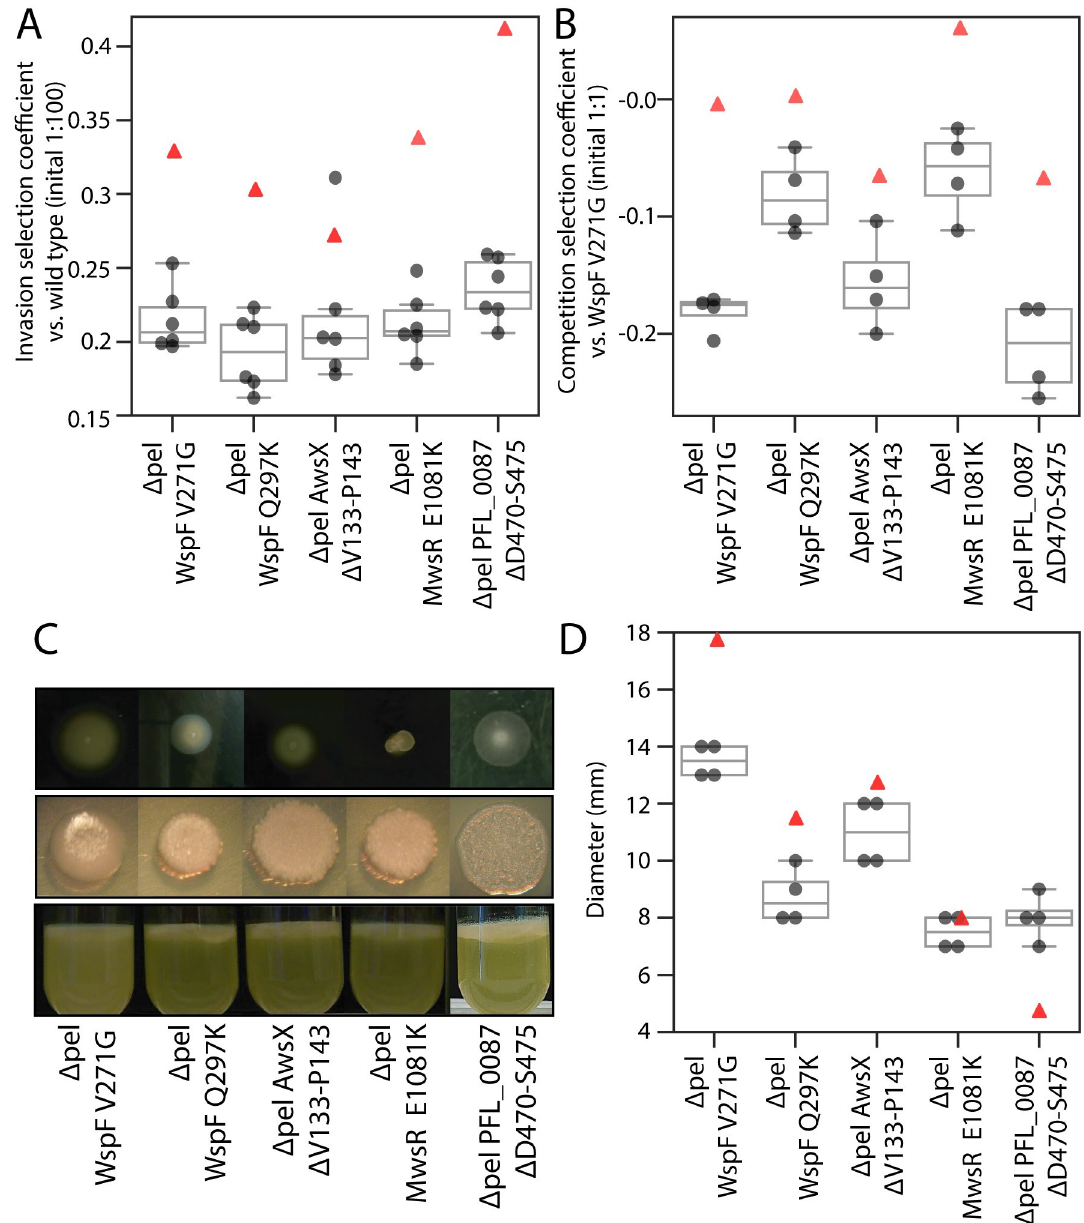
Fig 6. Contribution of pel to WS phenotype and fitness. ( A ). Deletion of pel in WS mutants reduces invasion fitness (mean values of intact pel mutants plotted as red triangle in all plots). Fitness of reconstructed P . protegens Pf-5 WS mutants without the pel operon was measured in pairwise competitions. Invasion fitness was measured relative a dominant ancestral wild type strain with a 1:100 initial ratio. Six independent competitions were performed for each pair. ( B ) Deletion of pel in WS mutants reduces competition fitness. Competition fitness was measured relative the most common WS mutant (WspF V271G) in a 1:1 initial ratio. Four independent competitions were performed for each pair. ( C ) Deletion of pel in WS mutants did not result in ancestral smooth colony morphology or loss of ability to colonize the air-liquid interface suggesting a secondary EPS component is produced. ( D ). Deletion of pel did not restore motility showing that Pel overproduction is not the cause of the motility defect in WS mutants. Four replicates on two separate plates per strain were